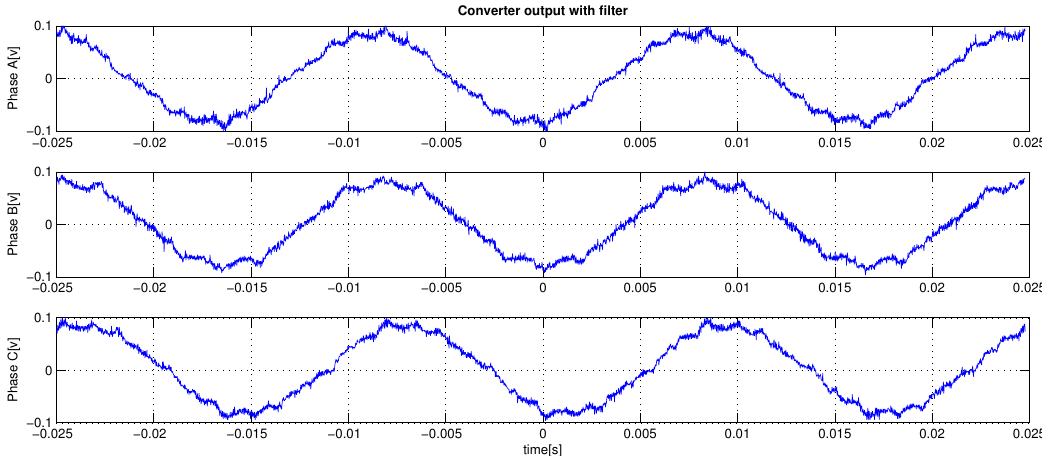
Figure 17. Graph of converter outputs with the filter (measurements